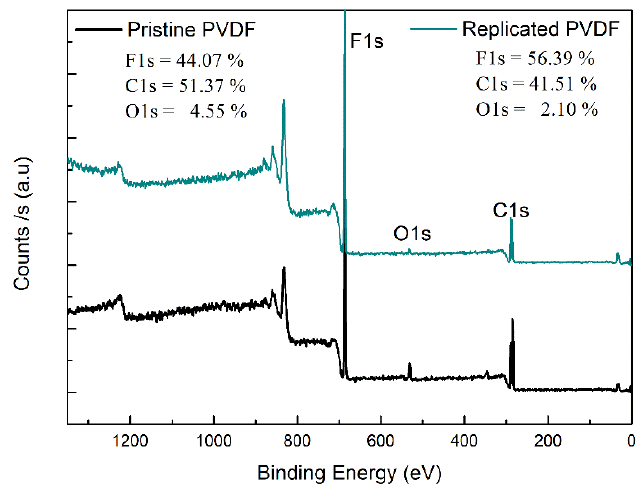
Figure 3. X-Ray photoelectron spectroscopy (XPS) wide survey spectra scan: Pristine PVDF (black line) and Replicated PVDF (colored line).